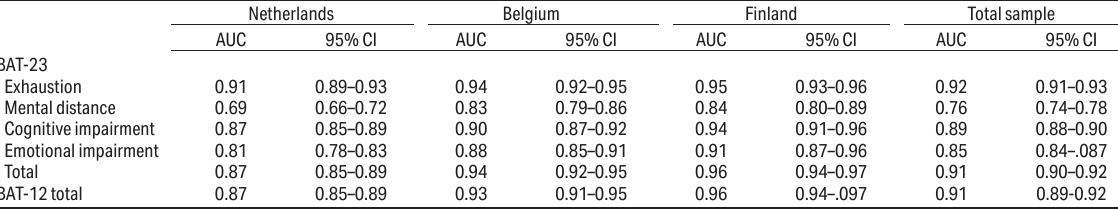
Table 2. Area under the curve (AUC) [BAT=Burnout Assessment Tool; CI=confidence interval].